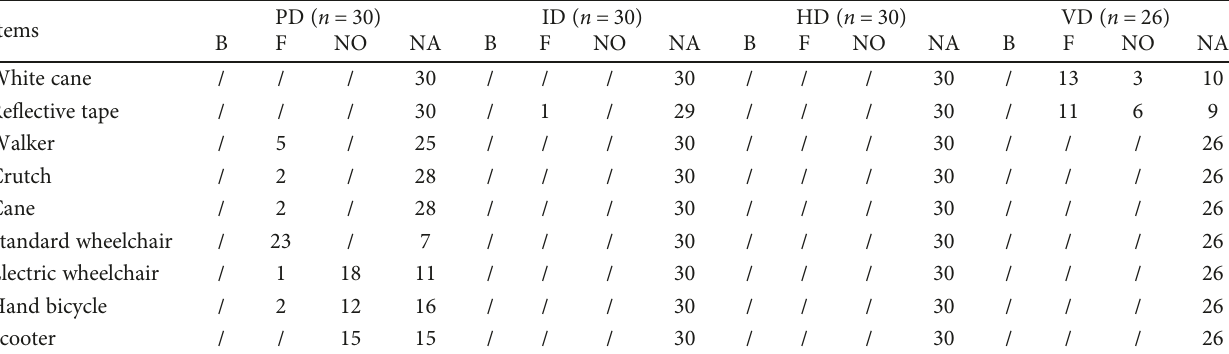
Table 3: Facilitators and barriers of AT for mobility.